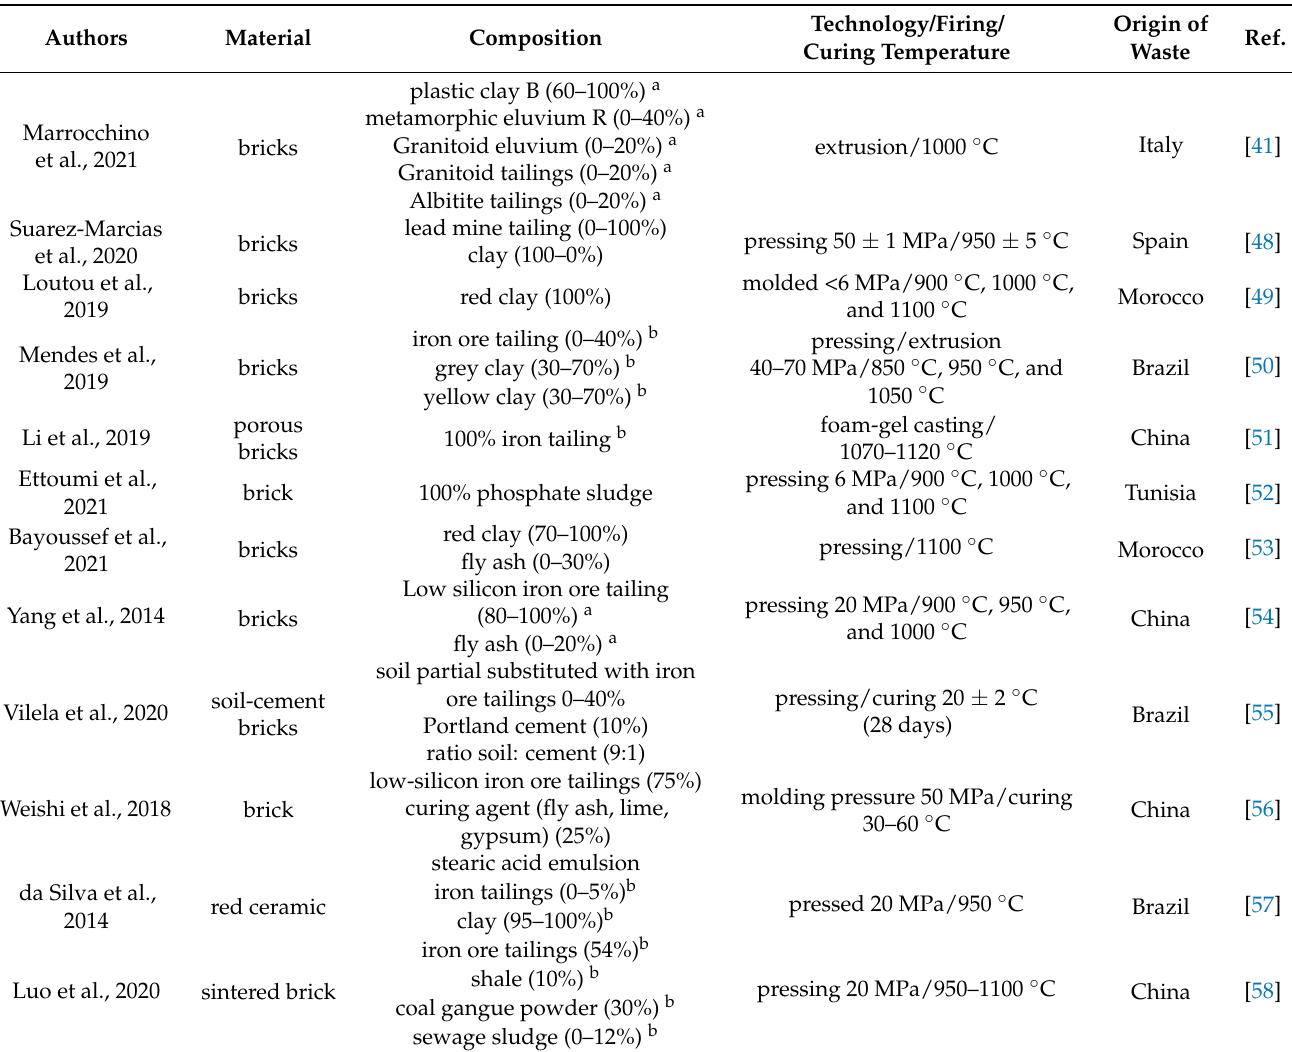
Table 2. Types of mining waste used in